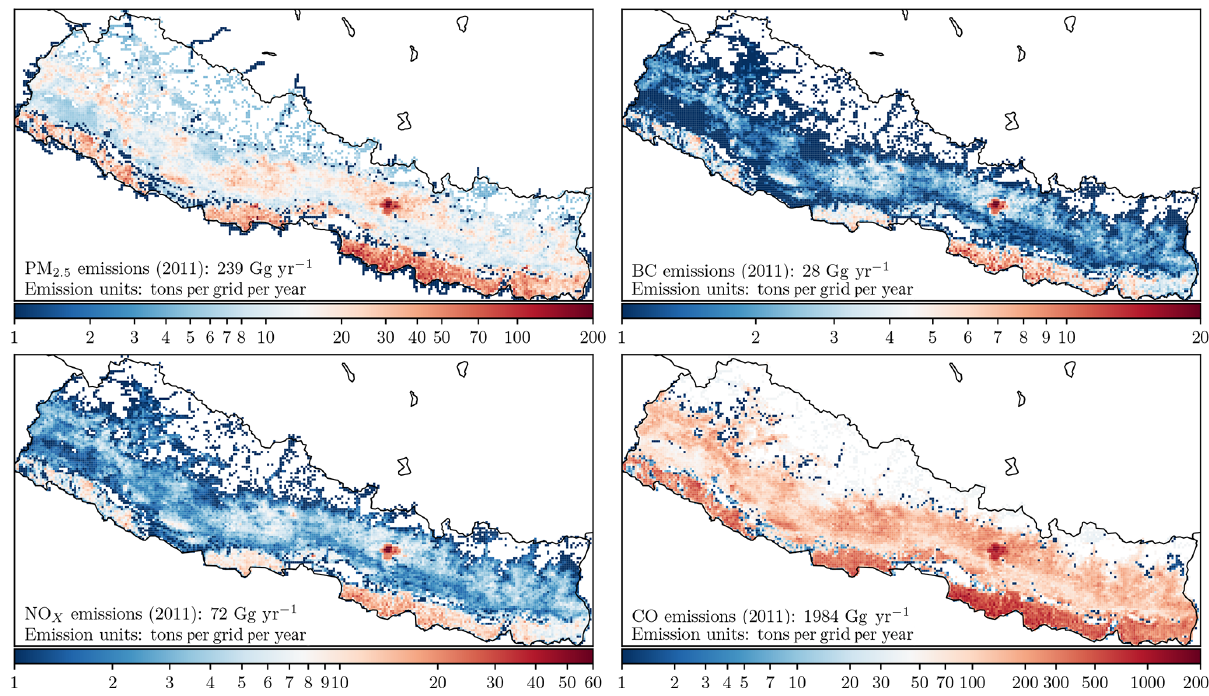
Figure 8. Spatial distributions of PM 2 . 5 , BC, NO x and CO emissions for year 2011.